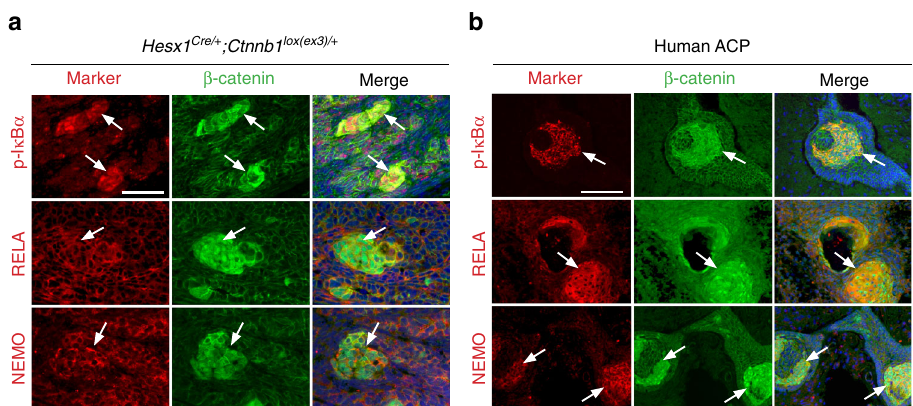
Fig. 3 Cluster cells show activation of the NF κ B pathway. Double immunostaining on histological sections of Hesx1 Cre/ + ;Ctnnb1 lox(ex3)/ + pre-tumoural pituitaries at 18.5dpc ( a ) and human ACP tumours ( b ). Phospho-I κ B α , a readout of activated NF κ B pathway, as well as RELA and NEMO, two components of this pathway, are expressed in cluster cells (white arrows). Results are representative of experiments conducted in four to six mice. Scale bar: a 50 μ m; b 100